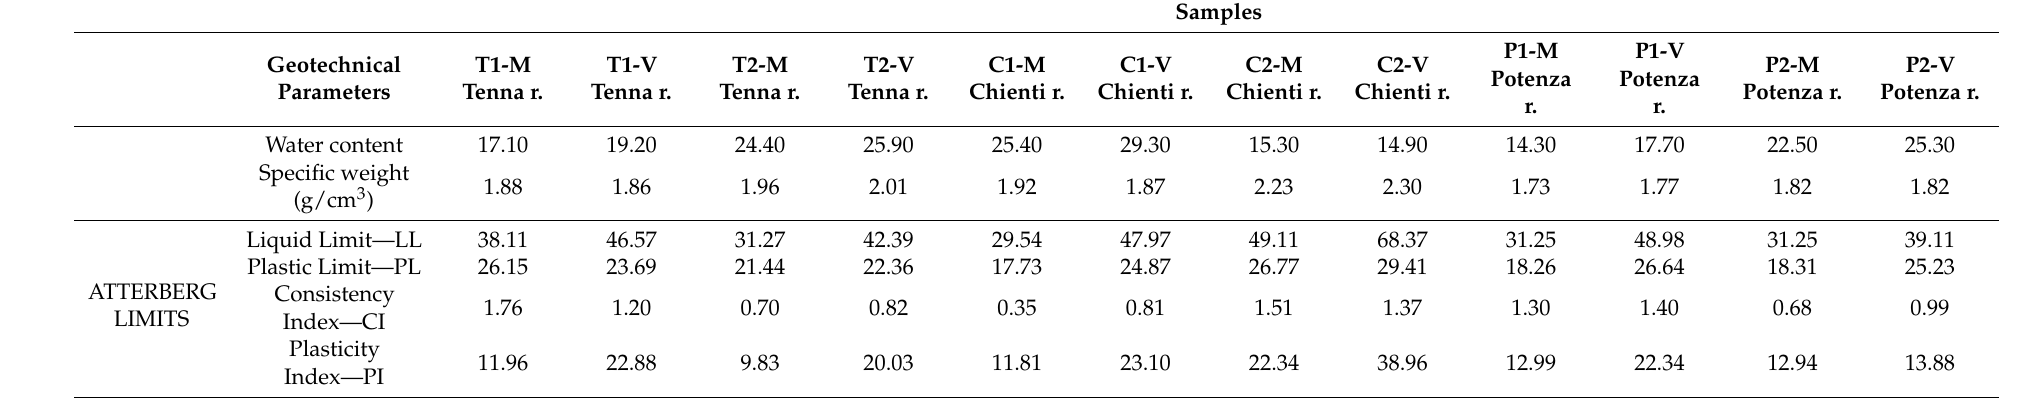
Table 2. Results of the geotechnical analyses carried out on the 12 samples of water taken in correspondence with the sample